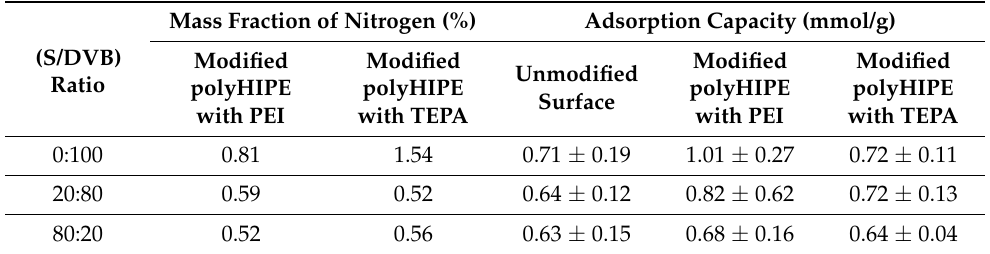
Table 2. CO 2 adsorption of poly(S/DVB)HIPE between the unmodified and amine-modified surface.